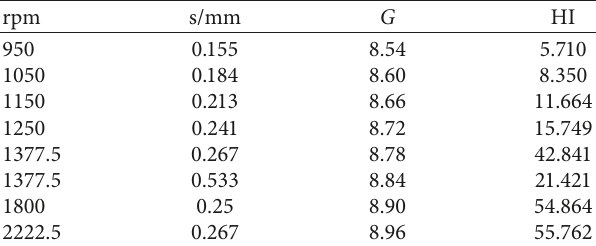
Table 13: ASTM grains size number versus heat index regression. rpm s/mm G